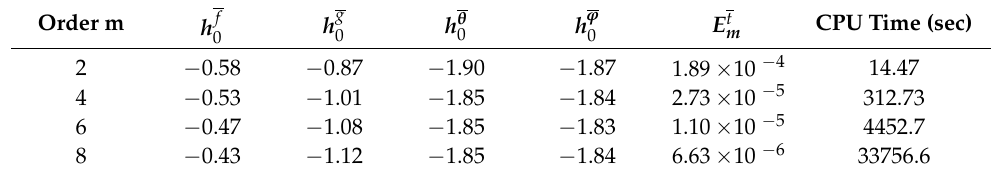
Table 1. Optimal convergence control parameter values and total averaged squared residual errors